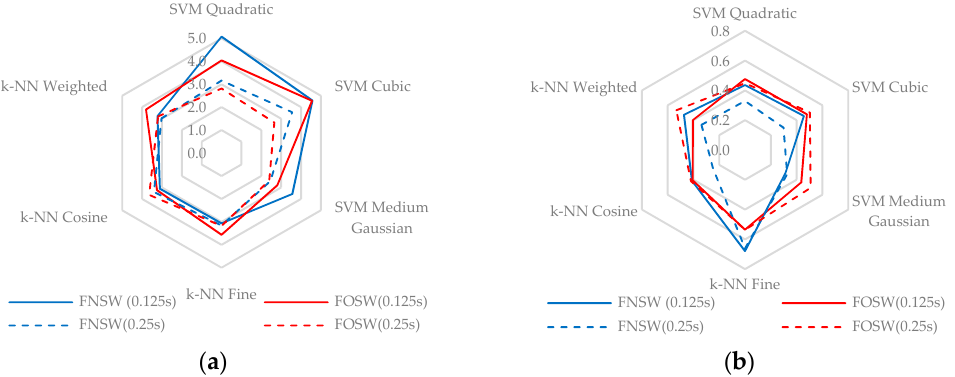
Figure 3. Percentage misclassifications: ( a ) FN and ( b ) FP for each classifier during the testing